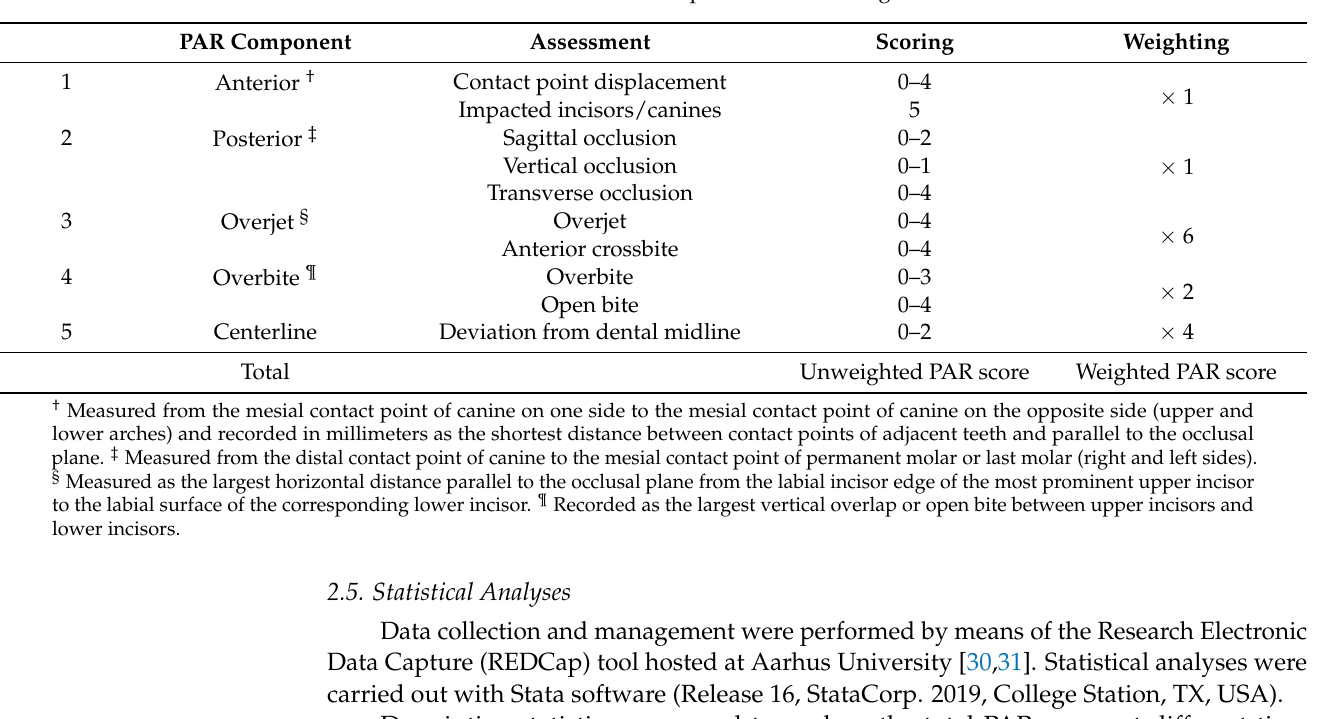
Table 1. The PAR index components and